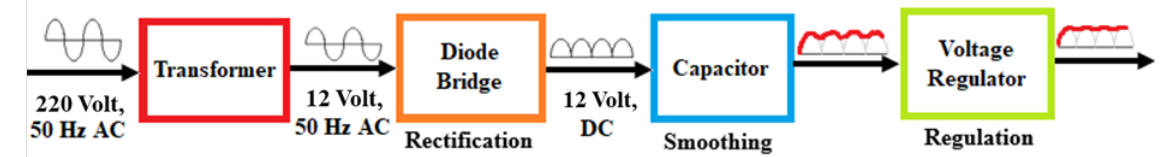
Figure 2. Schematic of the Electrical Circuit.